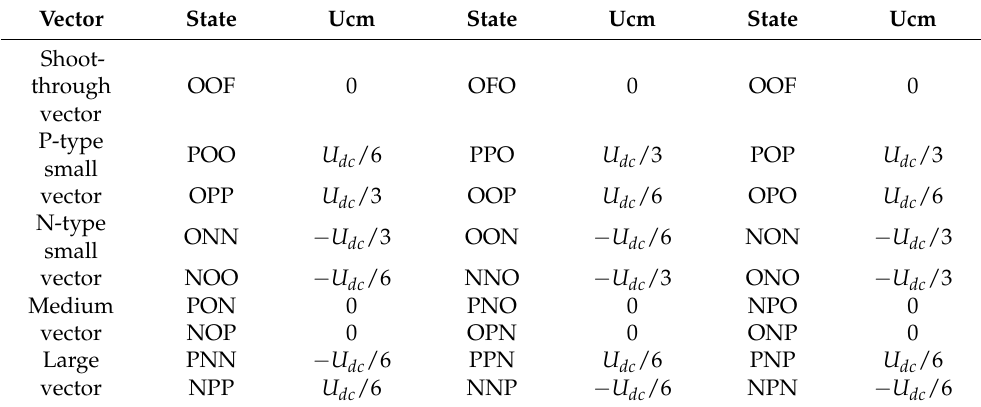
Table 2. The corresponding relationship between vector and common-mode voltage.